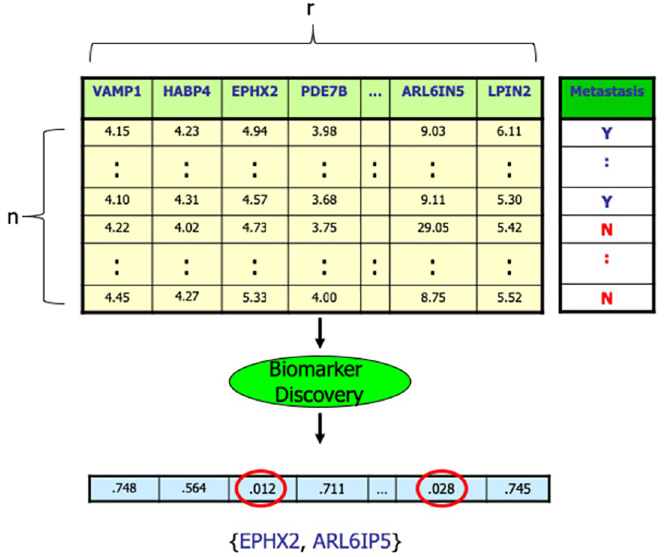
Fig 1. Data matrix, showing t-test p-values for each (shown) feature for the GSE 7390 dataset [14], with respect to the group outcome (here “Metastasis” for breast cancer). The circled features, with p < 0.05, are (purported) biomarkers. For notation: We will refer to each of the first r columns of the matrix as a “feature”; these are often called “(independent) variables”. We refer to the final column as a “outcome”– e.g. , case versus control (shown here as Y versus N)–these are often called “labels”, “dependent variables”, “groups”, “phenotypes” or “classes”. Finally, we will use “subject” to refer to each row of that matrix; these are sometimes called “instances” or